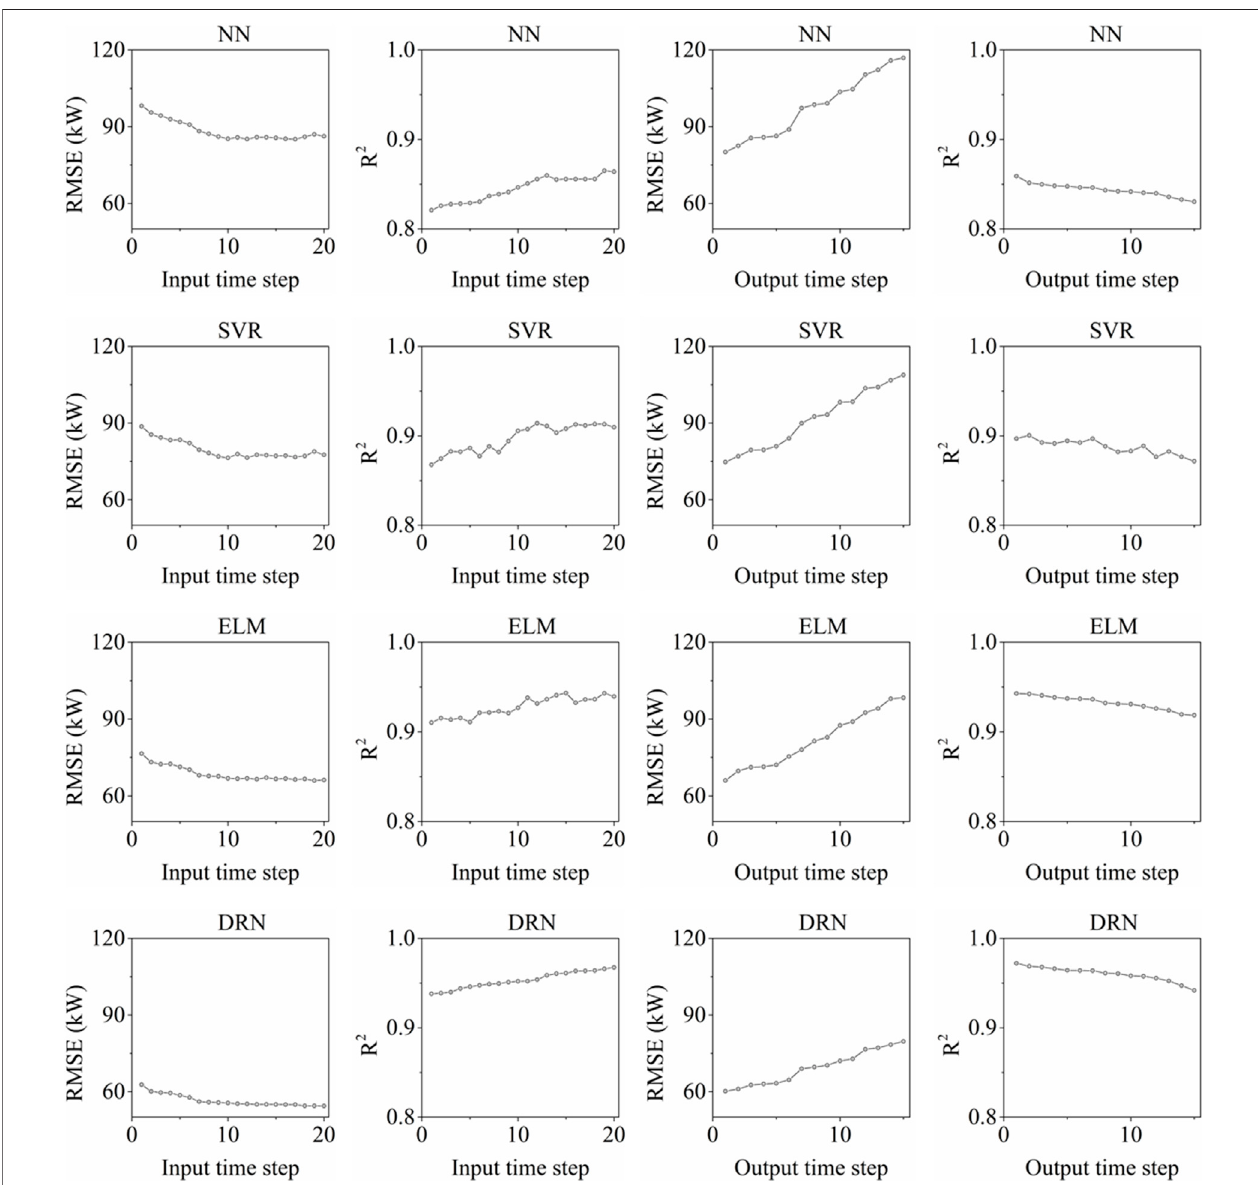
FIGURE 4 | Impact of input/output size on the prediction